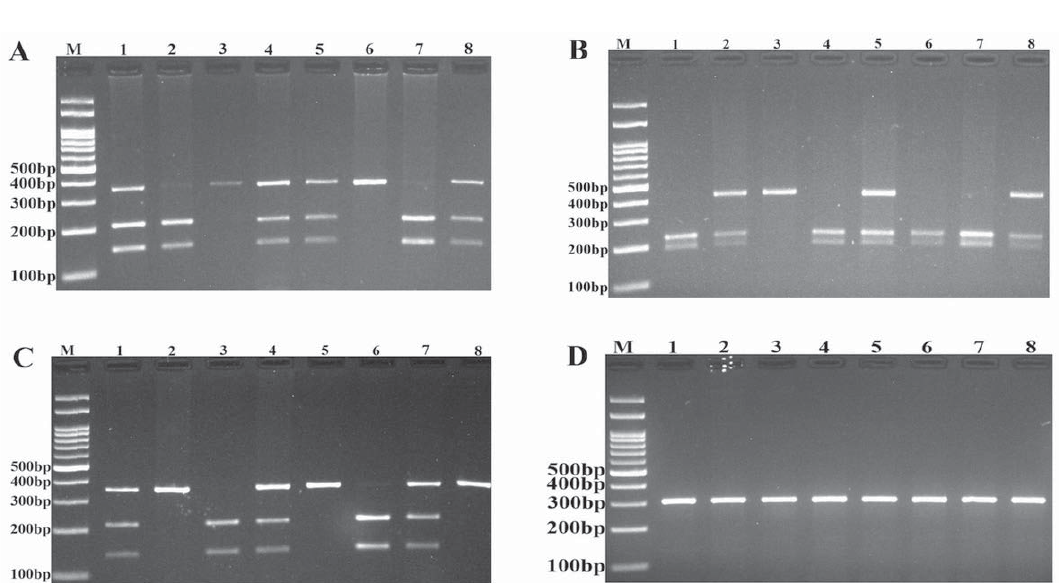
Figure 2- Photograph of electrophoresis pattern of the PCR-RFLP method for detection of AXIN2 rs7224837 (A), BMP4 rs17563 (B), IRF6 (cid:85)(cid:86)(cid:27)(cid:25)(cid:20)(cid:19)(cid:20)(cid:28)(cid:3)(cid:11)(cid:38)(cid:12)(cid:3)(cid:68)(cid:81)(cid:71)(cid:3)(cid:44)(cid:53)(cid:41)(cid:25)(cid:3)(cid:21)(cid:21)(cid:22)(cid:24)(cid:22)(cid:26)(cid:20)(cid:3)(cid:11)(cid:39)(cid:12)(cid:17)(cid:3)(cid:48)(cid:29)(cid:3)(cid:39)(cid:49)(cid:36)(cid:3)(cid:80)(cid:68)(cid:85)(cid:78)(cid:72)(cid:85)(cid:17)(cid:3)(cid:41)(cid:82)(cid:85)(cid:3)(cid:36)(cid:59)(cid:44)(cid:49)(cid:21)(cid:3)(cid:85)(cid:86)(cid:26)(cid:21)(cid:21)(cid:23)(cid:27)(cid:22)(cid:26)(cid:3)(cid:89)(cid:68)(cid:85)(cid:76)(cid:68)(cid:81)(cid:87)(cid:15)(cid:3)(cid:79)(cid:68)(cid:81)(cid:72)(cid:86)(cid:3)(cid:20)(cid:15)(cid:3)(cid:23)(cid:15)(cid:3)(cid:24)(cid:15)(cid:3)(cid:68)(cid:81)(cid:71)(cid:3)(cid:27)(cid:29)(cid:3)(cid:36)(cid:42)(cid:30)(cid:3)(cid:79)(cid:68)(cid:81)(cid:72)(cid:86)(cid:3)(cid:21)(cid:15)(cid:3)(cid:68)(cid:81)(cid:71)(cid:3)(cid:26)(cid:29)(cid:3)(cid:36)(cid:36)(cid:30)(cid:3)(cid:79)(cid:68)(cid:81)(cid:72)(cid:86)(cid:3)(cid:22)(cid:15)(cid:3) (cid:68)(cid:81)(cid:71)(cid:3)(cid:25)(cid:29)(cid:3)(cid:36)(cid:36)(cid:17)(cid:3)(cid:41)(cid:82)(cid:85)(cid:3)(cid:37)(cid:48)(cid:51)(cid:23)(cid:3)(cid:85)(cid:86)(cid:20)(cid:26)(cid:24)(cid:25)(cid:22)(cid:3)(cid:83)(cid:82)(cid:79)(cid:92)(cid:80)(cid:82)(cid:85)(cid:83)(cid:75)(cid:76)(cid:86)(cid:80)(cid:15)(cid:3)(cid:79)(cid:68)(cid:81)(cid:72)(cid:86)(cid:3)(cid:20)(cid:15)(cid:3)(cid:23)(cid:15)(cid:3)(cid:25)(cid:15)(cid:3)(cid:68)(cid:81)(cid:71)(cid:3)(cid:26)(cid:29)(cid:3)(cid:55)(cid:55)(cid:30)(cid:3)(cid:79)(cid:68)(cid:81)(cid:72)(cid:86)(cid:3)(cid:21)(cid:15)(cid:3)(cid:24)(cid:15)(cid:3)(cid:68)(cid:81)(cid:71)(cid:3)(cid:27)(cid:29)(cid:3)(cid:38)(cid:55)(cid:30)(cid:3)(cid:79)(cid:68)(cid:81)(cid:72)(cid:3)(cid:22)(cid:29)(cid:3)(cid:38)(cid:38)(cid:17)(cid:3)(cid:41)(cid:82)(cid:85)(cid:3)(cid:44)(cid:53)(cid:41)(cid:25)(cid:3)(cid:85)(cid:86)(cid:27)(cid:25)(cid:20)(cid:19)(cid:20)(cid:28)(cid:3)(cid:89)(cid:68)(cid:85)(cid:76)(cid:68)(cid:81)(cid:87)(cid:15)(cid:3)(cid:79)(cid:68)(cid:81)(cid:72)(cid:86)(cid:3)